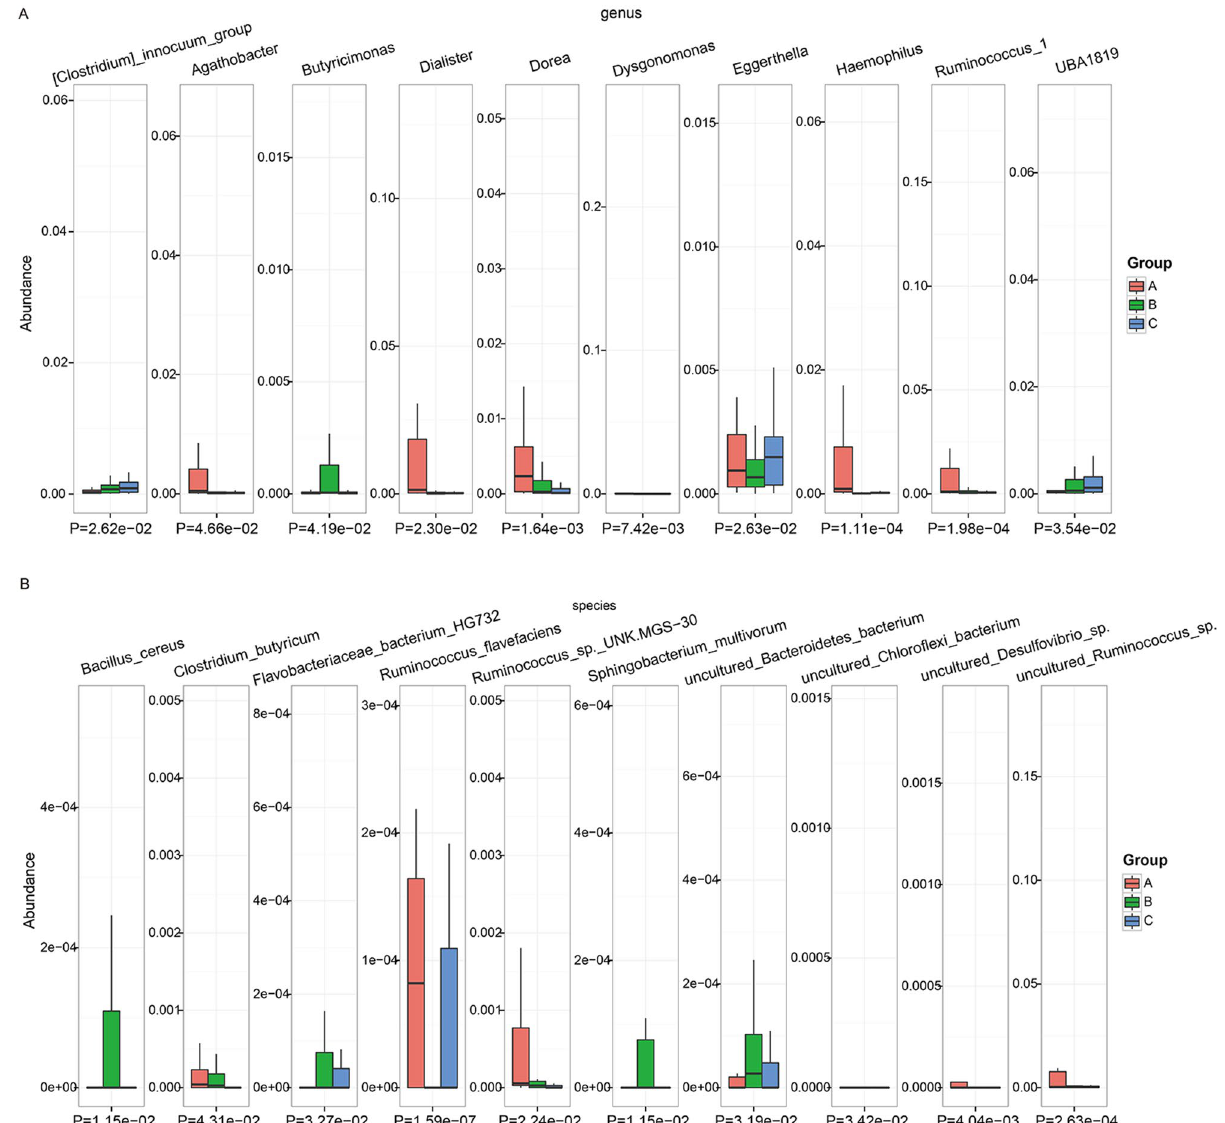
and (b) species levels. One-way ANOVA test was for a and